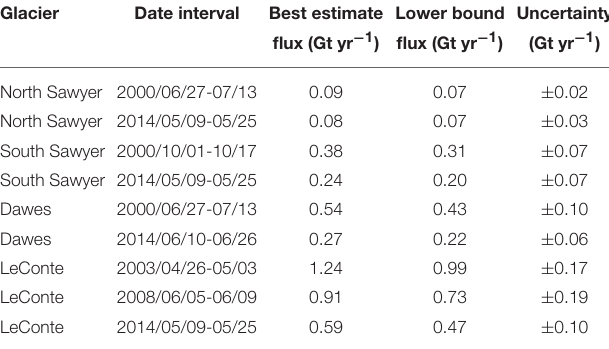
TABLE 1 | Frontal ablation flux estimates for North Sawyer, South Sawyer, Dawes and LeConte glaciers from selected velocity pairs between 2000 and